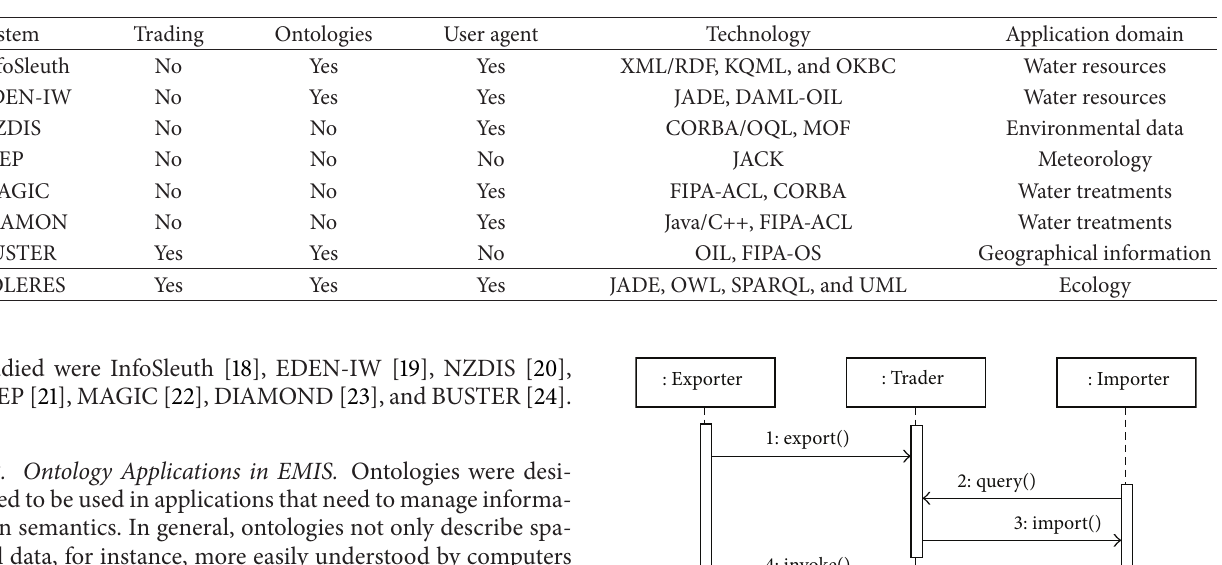
Table 1: A comparative view of some environmental management system architectures.